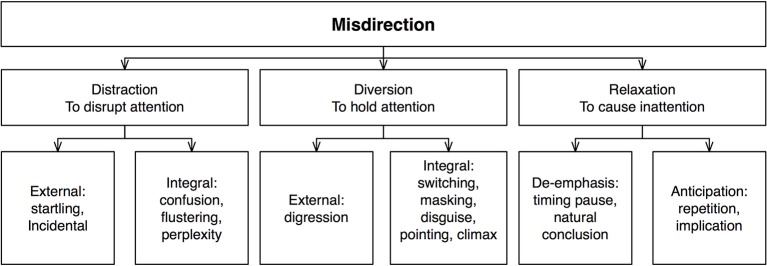
Schematic description of Bruno's (1978) taxonomy.